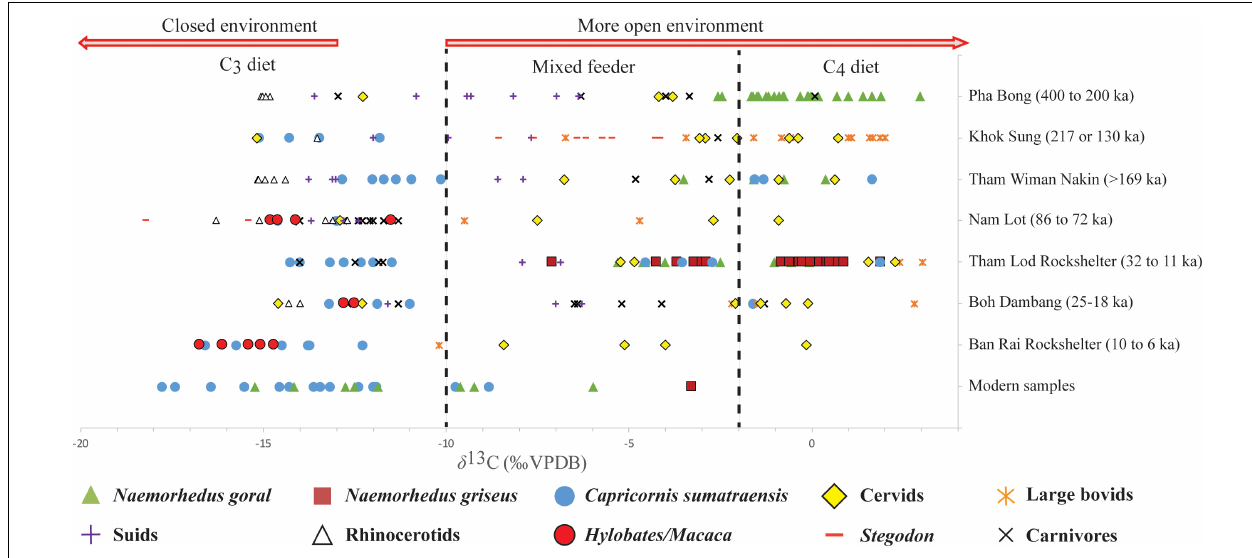
FIGURE 4 | Bulk δ 13 C values of mammals from several Pleistocene to Holocene caprine-bearing sites in Southeast Asia. In the tropics, the cut-off δ 13 C values of −